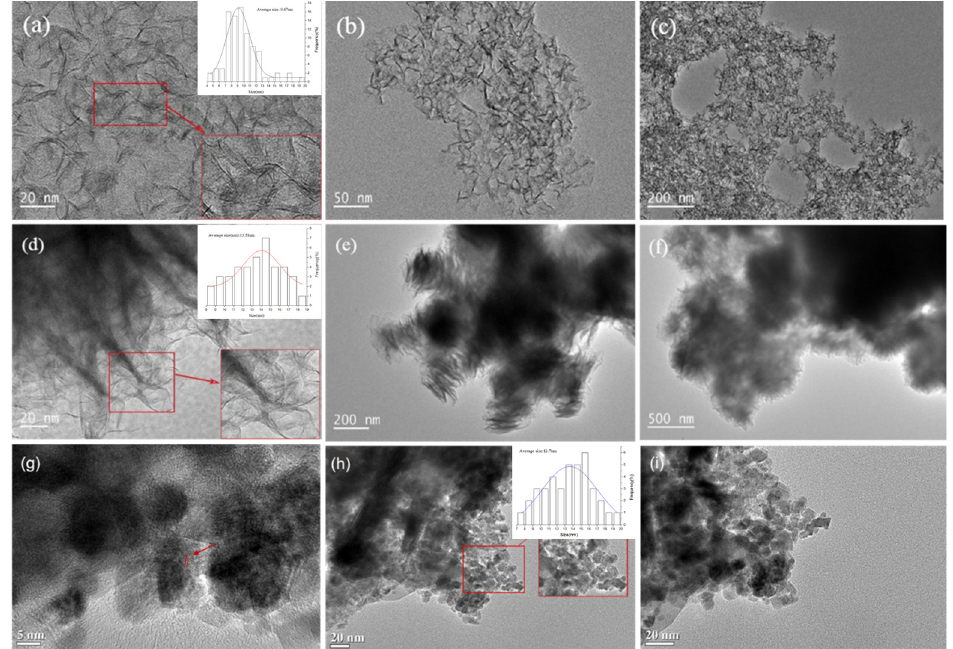
Figure 3. HRTEM pictures of catalysts, ( a – c ) O-MoS 2 , ( d – f ) W-MoS 2 , ( g – i ) Mo 2 C.